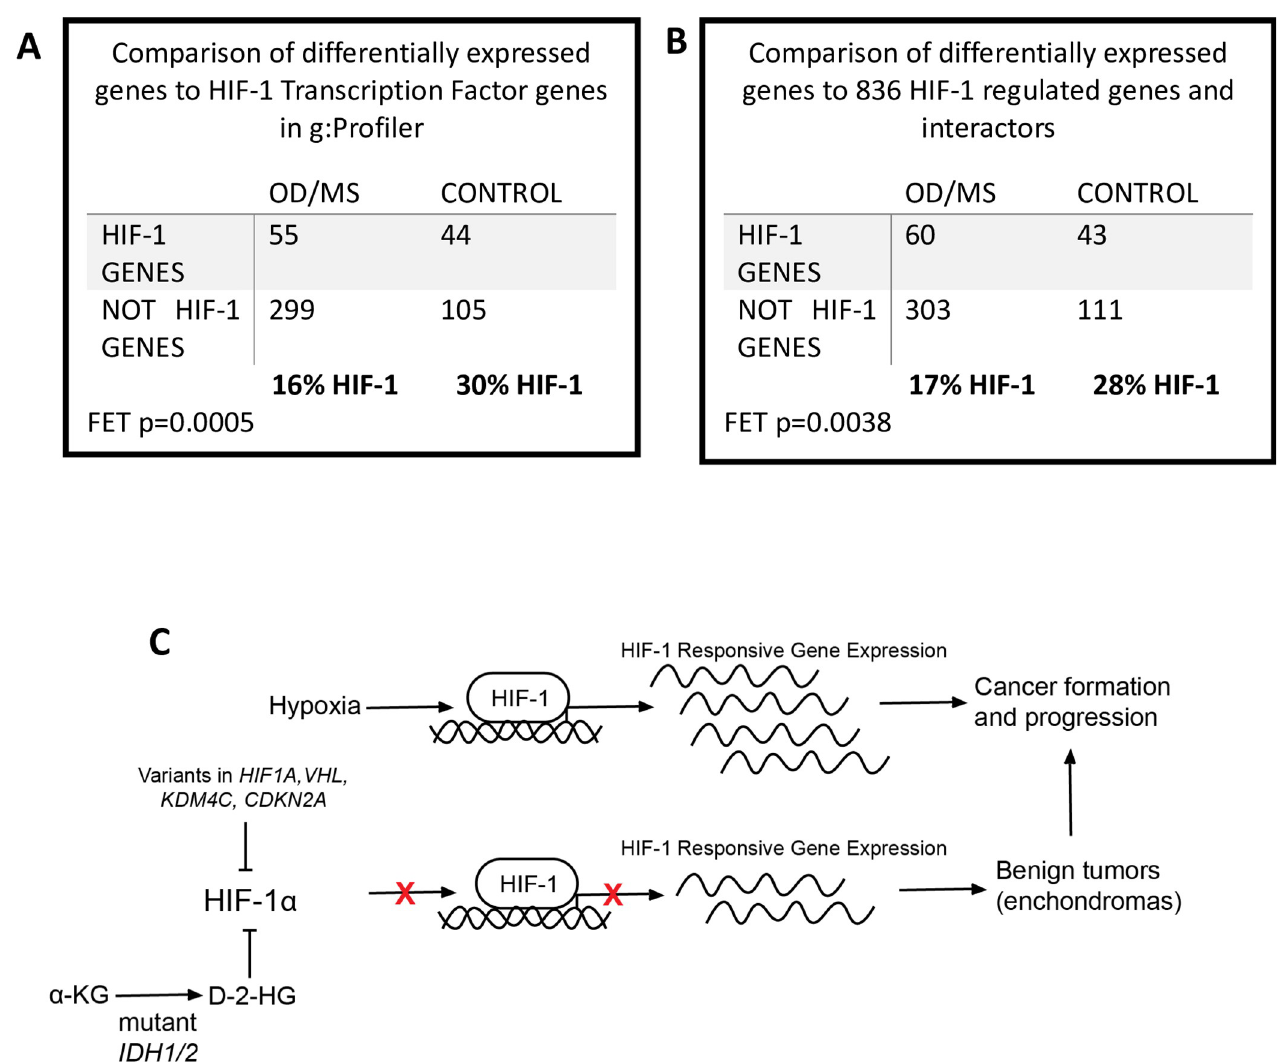
Fig 3. A. RNA-seq comparison of hypoxia-induced differentially expressed genes from primary fibroblasts from probands at hypoxia and hypoxia-induced differentially expressed genes from control fibroblasts at hypoxia (Table 3) to genes annotated as being regulated by the HIF-1 transcription factor by g:Profiler. B. RNA-seq comparison of hypoxia-induced differentially expressed genes from primary fibroblasts from probands at hypoxia and hypoxia-induced differentially expressed genes from control fibroblasts at hypoxia (Table 3) to curated list of HIF-1 regulated genes and interactors. C. Proposed mechanism of the role of the candidate causative variants in the HIF-1 pathway and the formation of enchondromas, vascular anomalies and chondrosarcomas in probands with OD and